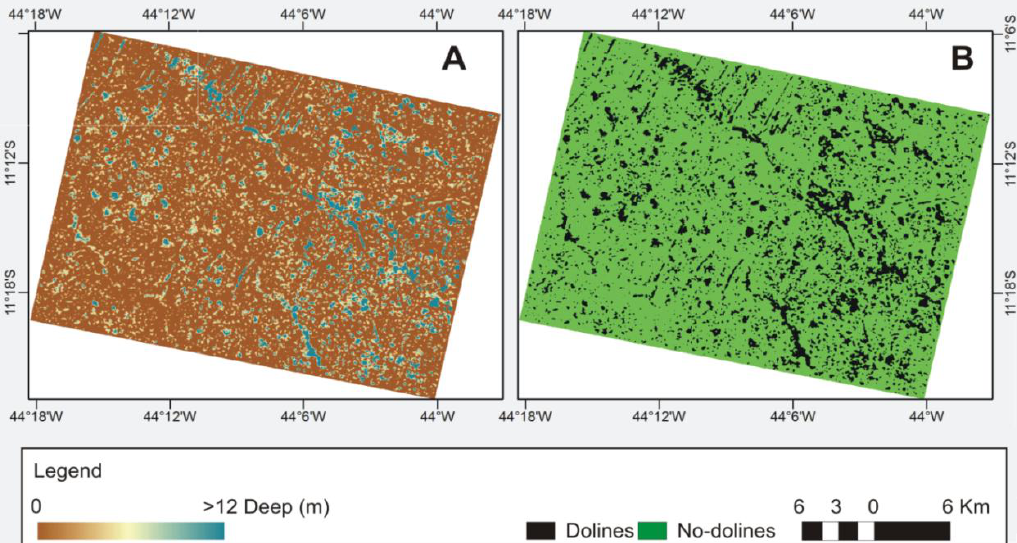
Figure 6. ( A ) Depth image and ( B ) its derived binary mask made from ASTER-GDEM data using threshold value of 1